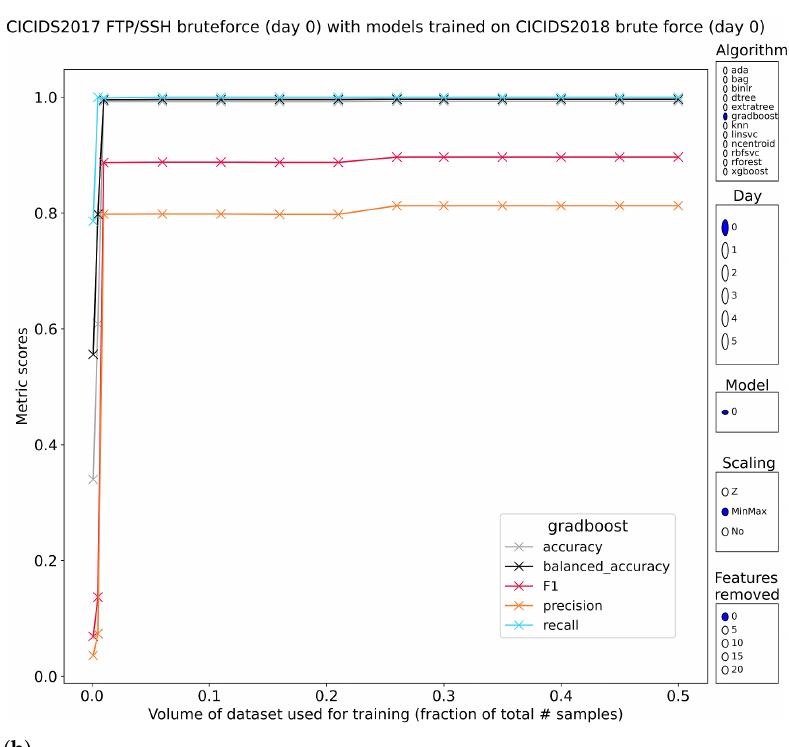
Figure 5. Best-case generalized performance of tree-based ensemble classifiers trained to recognize bruteforce attacks from CIC-IDS2017, when evaluating the bruteforce samples of